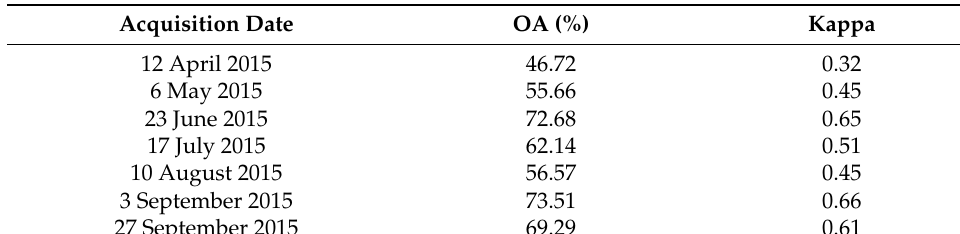
Table 7. Accuracy assessment of RF classifications with optimal combination of polarimetric ob- servables using single SAR image on each date.